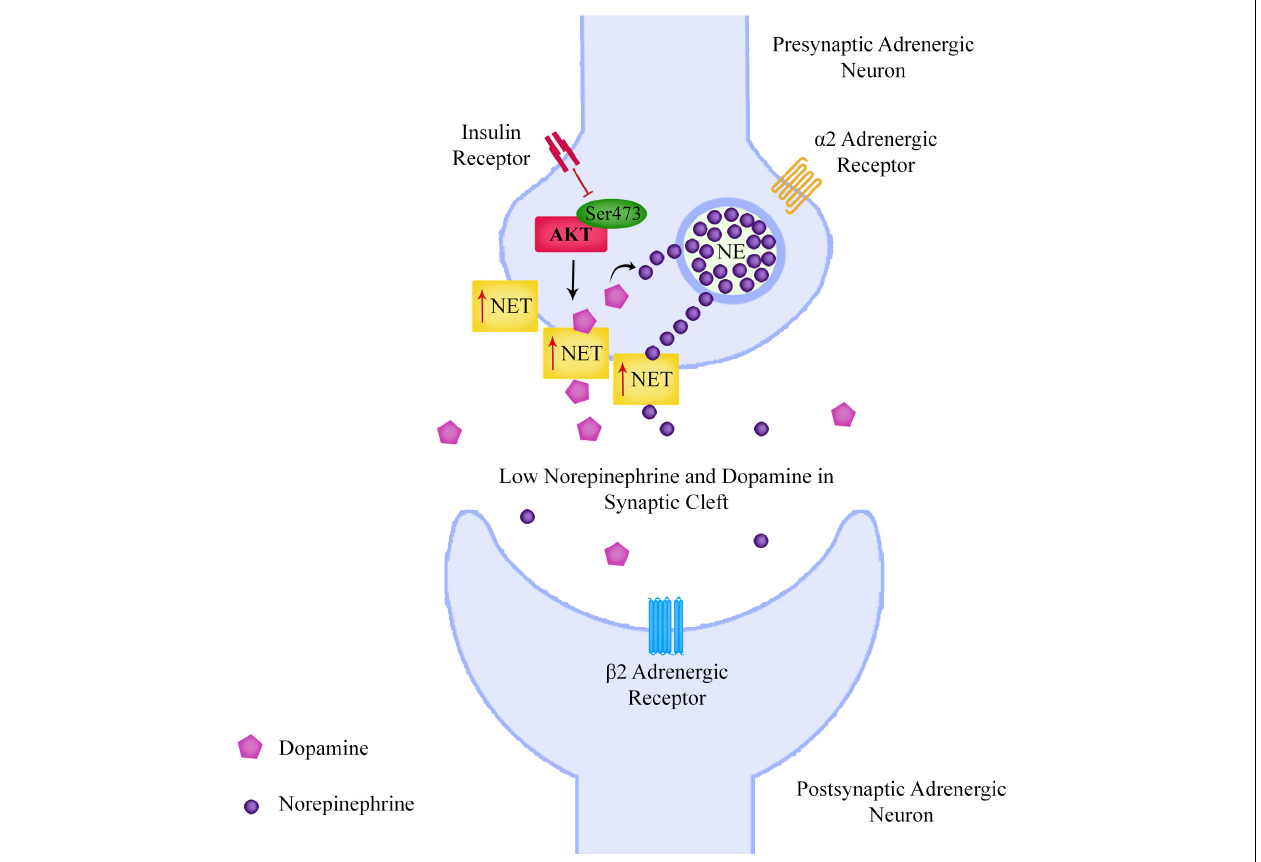
FIGURE 3 | Reduced neuronal Akt Ser473 phosphorylation leads to increased surface norepinephrine transporter expression, leading to an increased neuronal uptake of both norepinephrine and dopamine from the extracellular space, resulting in increased presynaptic conversion of dopamine to norepinephrine, with consequent lower levels of dopamine and higher levels of norepinephrine in vesicles of the presynaptic neurons. This could lead to lower levels of dopamine in the prefrontal cortex and also affect the signaling of the sympathetic nervous